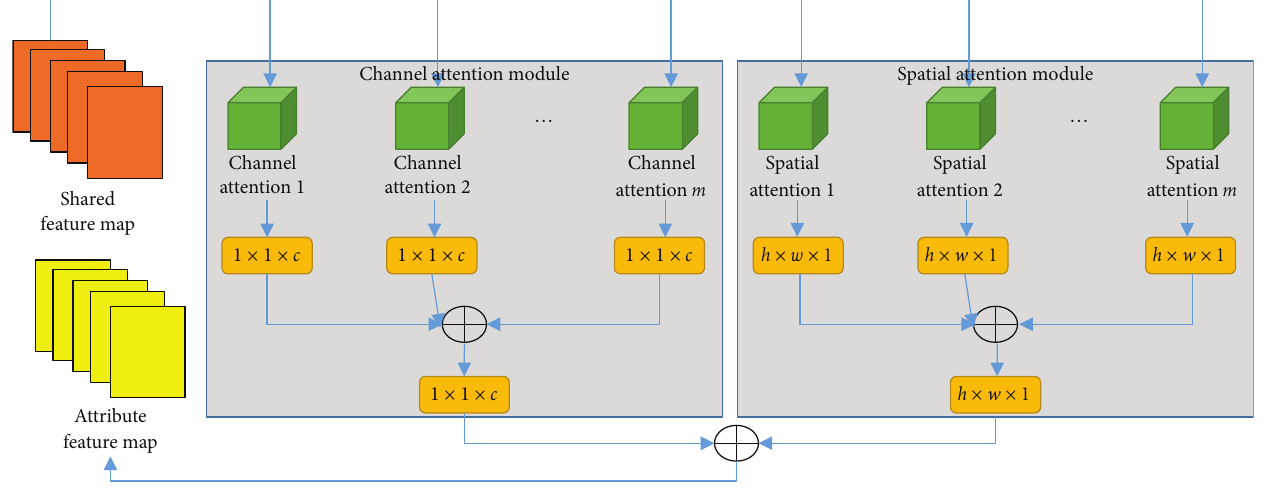
Figure 3: Multibranch spatial channel attention